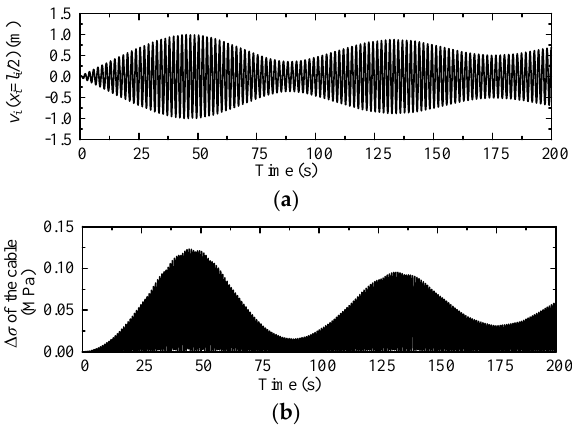
Figure 5. VIV response of the cable without the tube-cable coupling effect: ( a ) displacement in the mid-section of cable; ( b ) cable stress variation (Δ σ ). Table 3. Comparisons between results with/without tube-cable coupling.